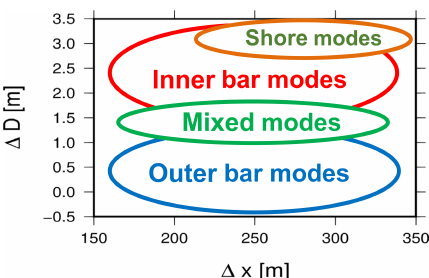
Figure 9. Sketch of the most likely fastest growing modes as a function of the geometry of the cross-shore profile. (cid:49)D represents the difference between the water depth over the two sandbar crests while (cid:49)x is the distance between the two sandbar crests.